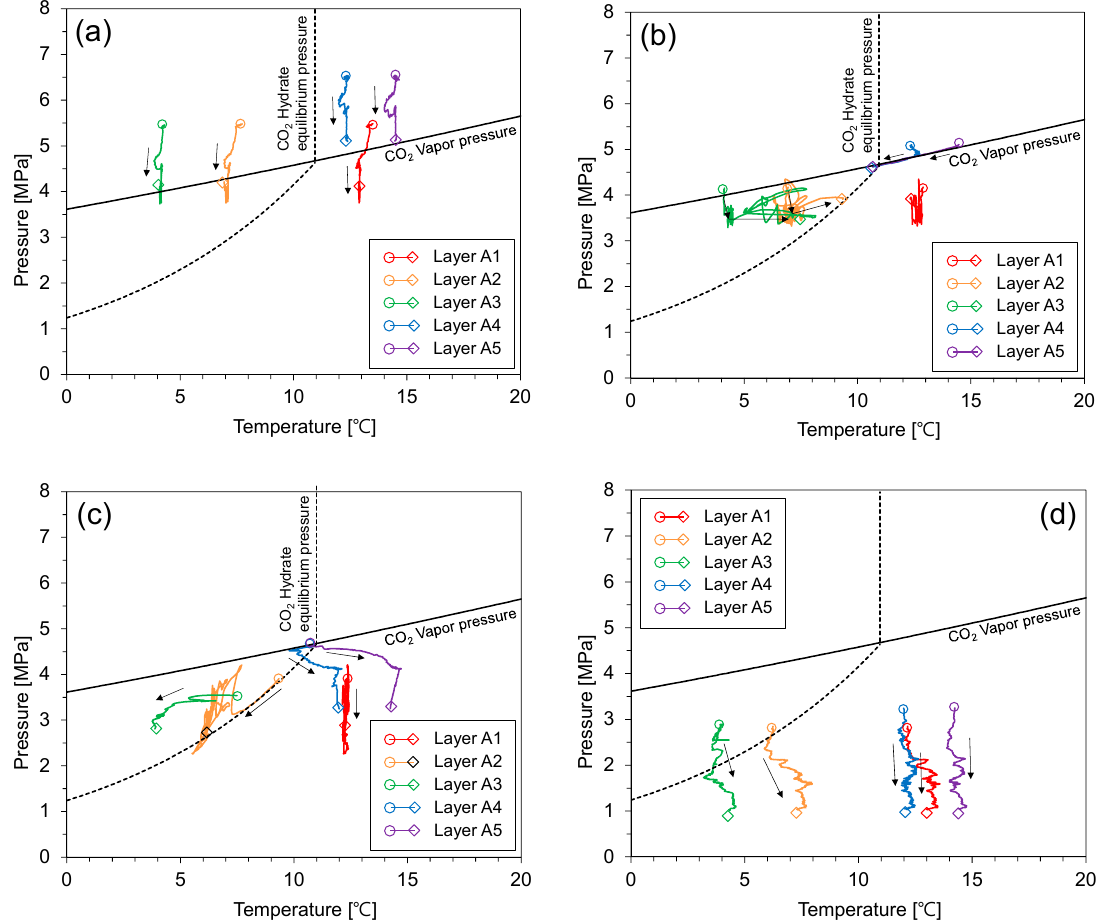
Figure 9. The pressure–temperature relationship during depressurization. ( a ) 0–980 min, ( b ) 980–1770 min, ( c ) 1770–3300 min, ( d ) 3300–8700 min.